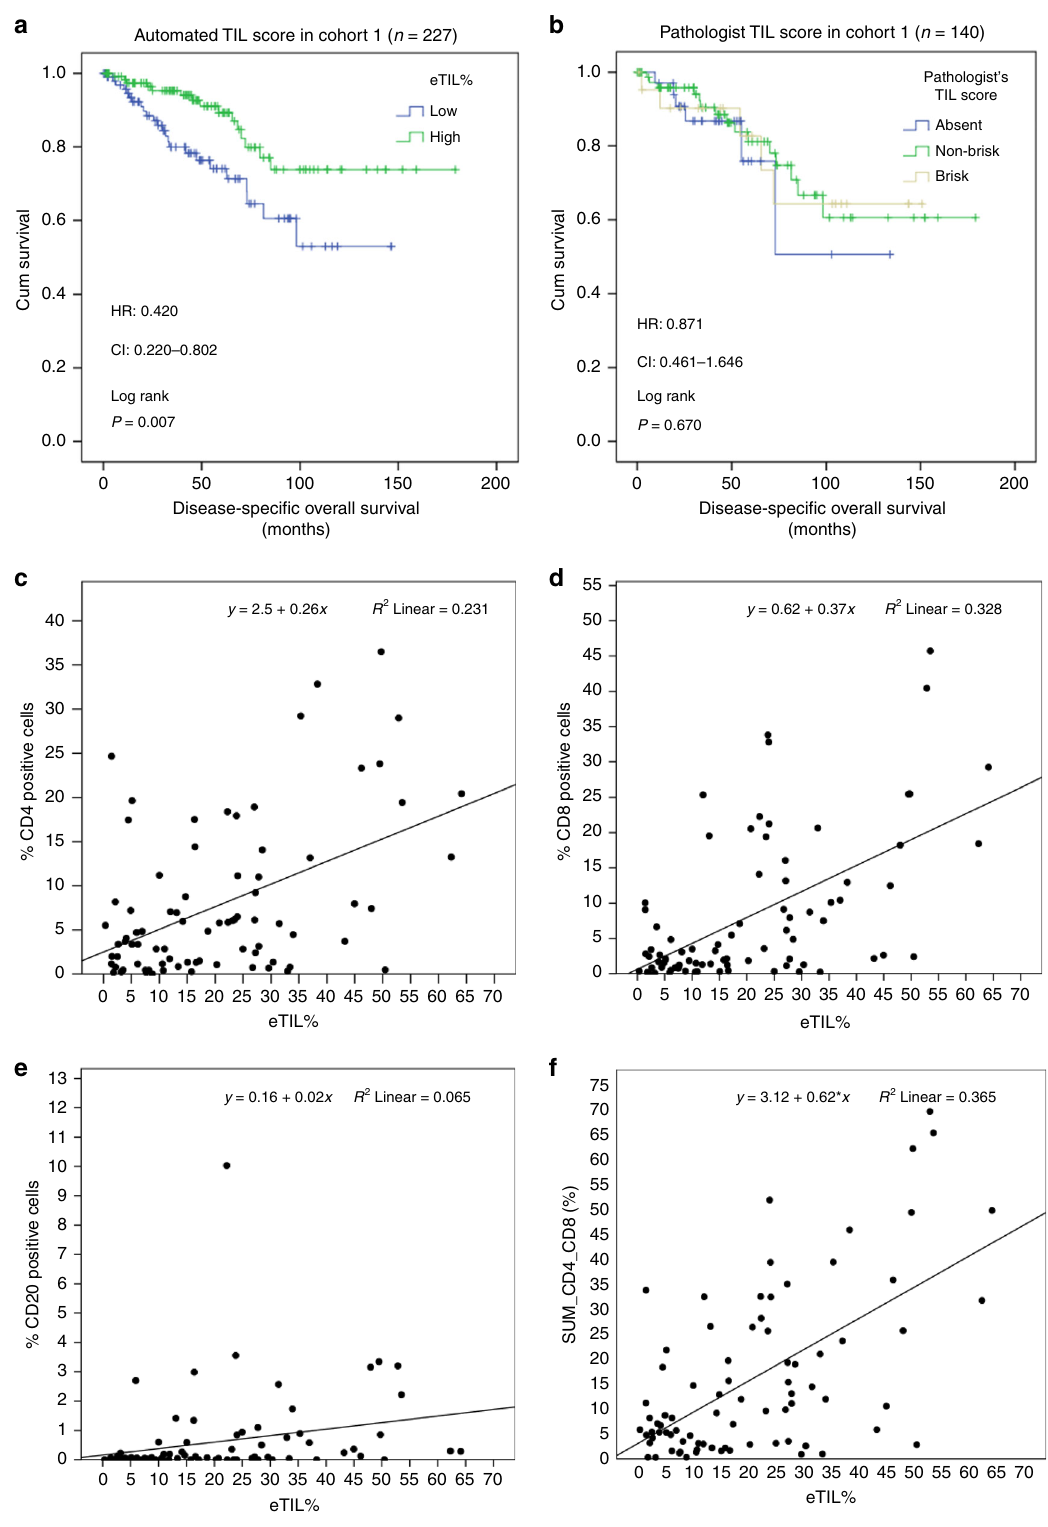
Fig. 1 Tumor-in fi ltrating lymphocytes (TIL) scores in cohort #1. The prognostic potential of automated TIL scores ( a ) and pathologist ’ s TIL scores ( b ) in cohort #1. Correlation between eTIL% scores and CD4 positive ( + ), CD8 + , and CD20 + immune cells measured by quantitative immuno fl uorescence ( c – f classi fi cation. The advantage of segmentation-based object obtained by DIA were linked with poor recurrence-free survival detection is that it requires relatively smaller of training used a similar approach, unsupervised nuclei segmentation fol- sets 13,27,28 . On the other hand, segmentation sensitivity and neural network machine-learning-based cell classi fi cation accuracy are subject to biological and technical